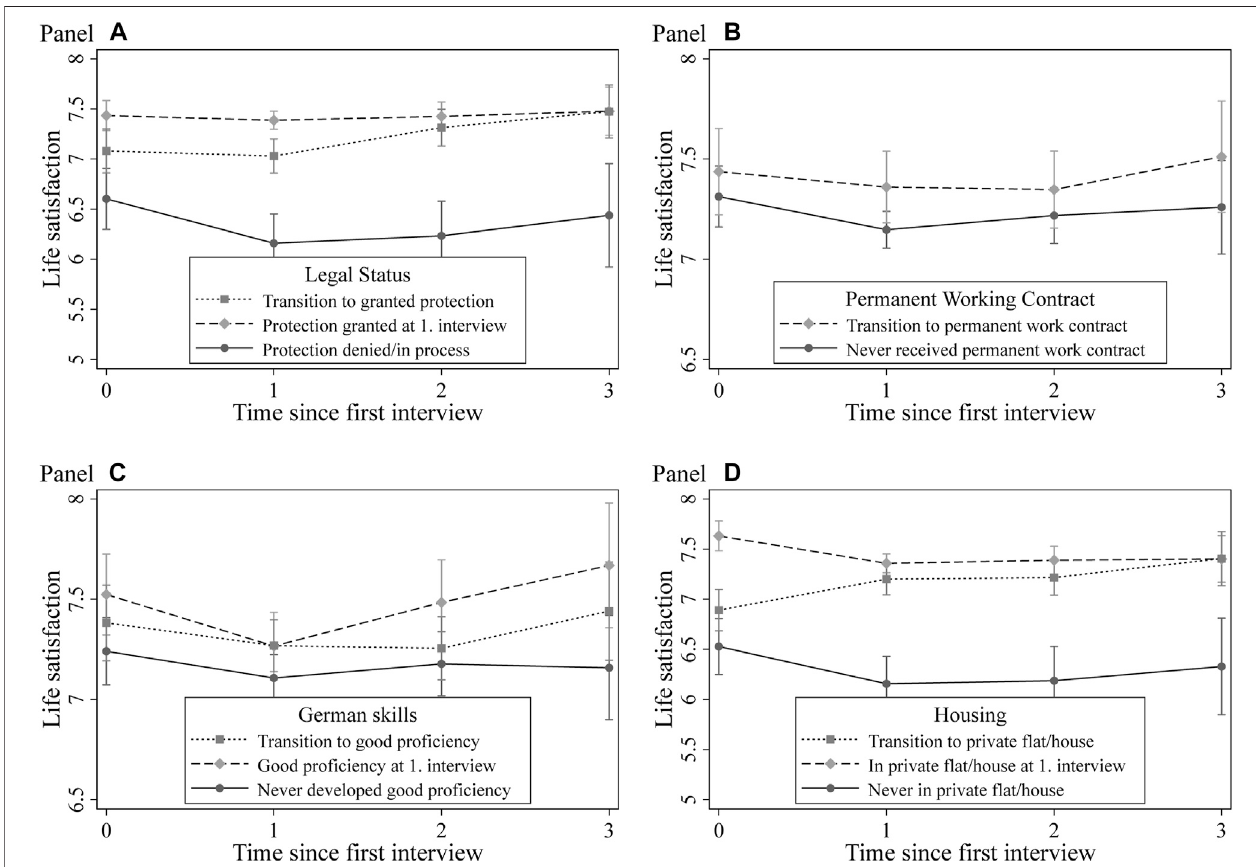
FIGURE 2 | Development of life satisfaction by postarrival mechanism. Note . Conditional pro fi le plots of the in fl uence of postarrival mechanisms on life satisfaction estimated by random effects growth curve models. The full regression results are displayed in Supplementary Table S7 (models S7.2 to S7.5). Dependent variables: overall life satisfaction (0 – 10). Control variables: gender, age, socioeconomic status before migration, arrival year, highest professional educational attainment, survey year fi xed effects, federal state fi xed effects, third person present at the interview, dummies indicating the number of interviews (panel conditioning), indicator for answering sensitive questions, and indicators for missing values in independent variables. Data : IAB-BAMF-SOEP Survey of Refugees, waves 1 – 4.